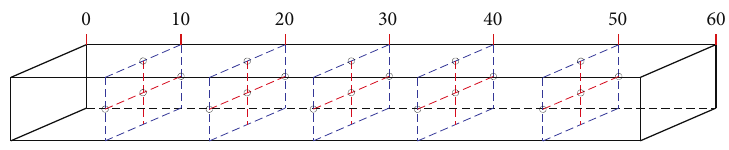
Figure 13: Monitoring scheme.